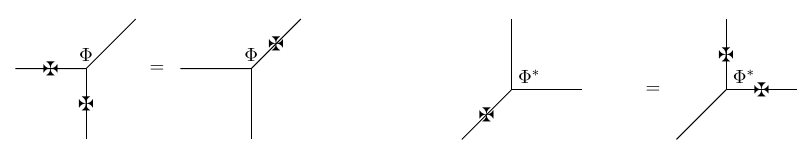
Figure 4 . Representation of the AFS lemma for the intertwiner and its dual, the symbol z denotes the insertion of an operator e 2 E